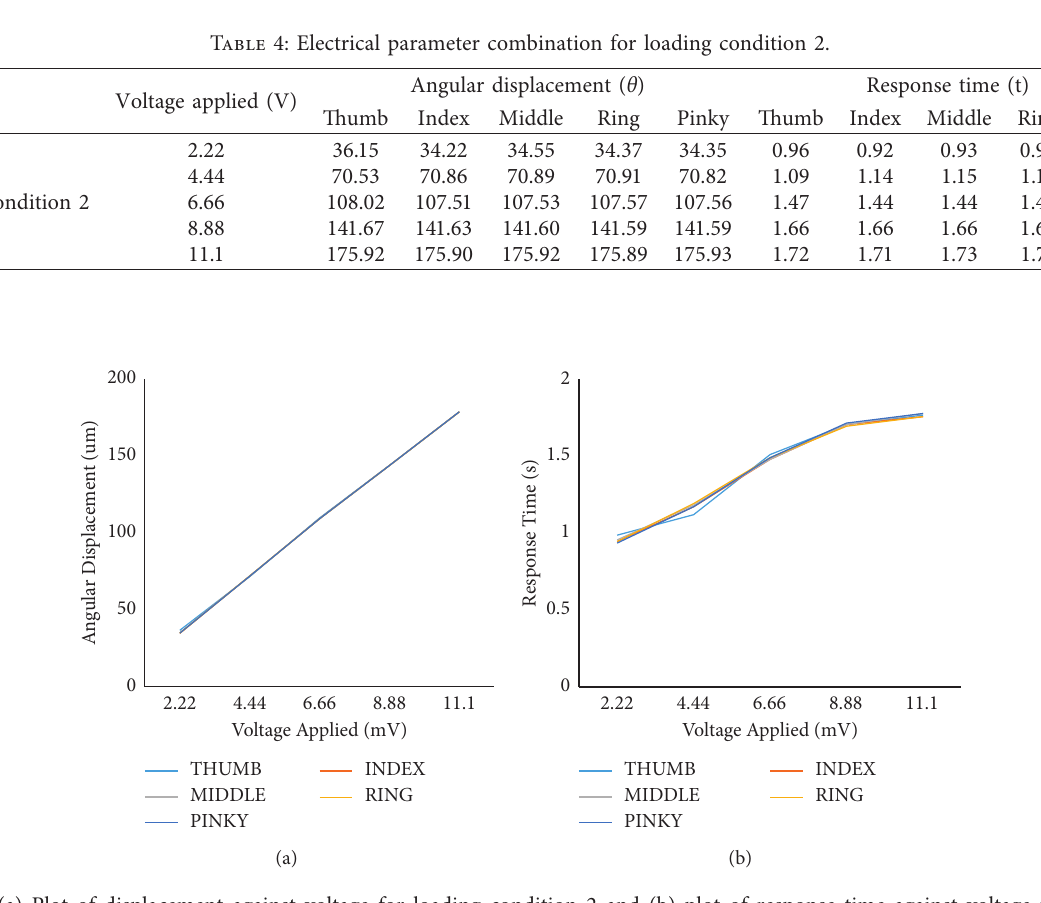
Figure 9: (a) Plot of displacement against voltage for loading condition 2 and (b) plot of response time against voltage for loading condition 2.